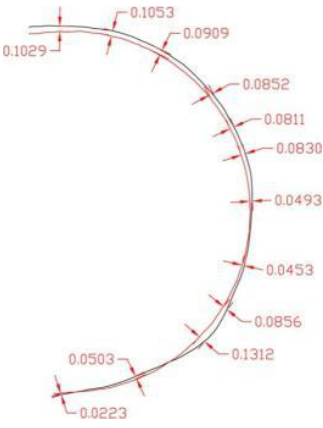
Figure 10. Graphical representation of the differences between LiDAR model and the recovered shape of the dome